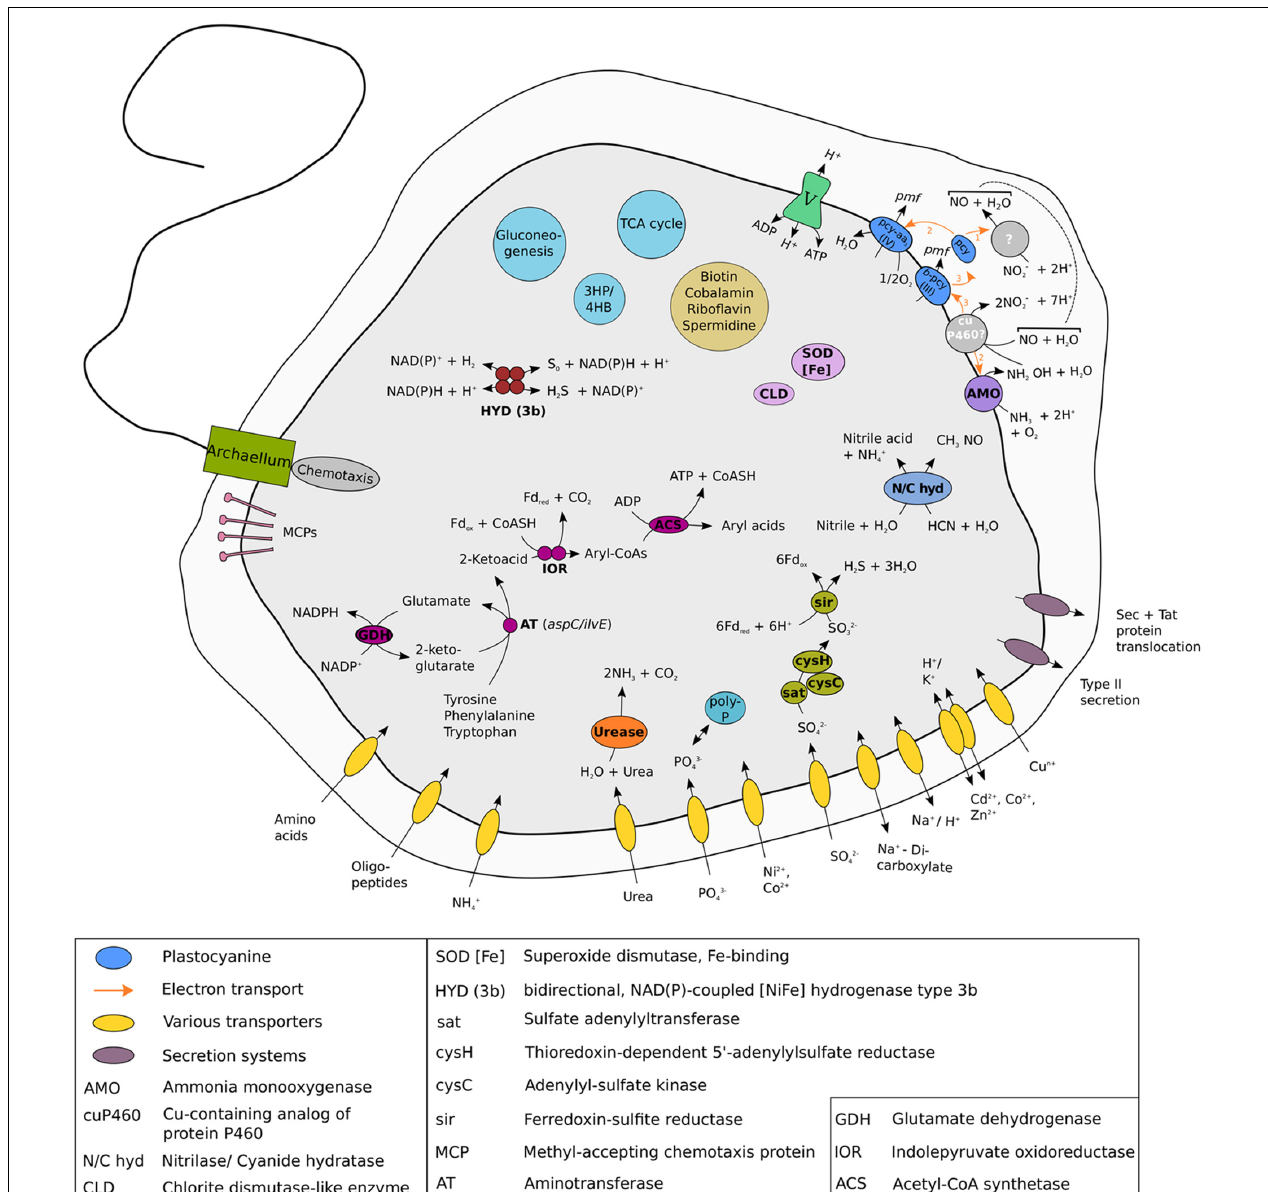
FIGURE 7 | Cell metabolic cartoon constructed from the annotation of the “ Ca. N. islandicus” genome. Enzyme complexes of the electron transport chain are labeled by Roman numerals. Most metabolic features displayed are discussed in the main text. The model of ammonia oxidation and electron transfer is depicted as proposed by Kozlowski et al. (2016). Locus tags of all genes discussed in the main text are given in Supplementary Table S4. Like some but not all AOA, “ Ca. N. islandicus” encodes all genes required to assemble an archaeal flagellar apparatus that is composed of the flagellar filament, the motor, and its switch (Mosier et al., 2012; Spang et al., 2012; Lebedeva et al., 2013; Lehtovirta-Morley et al., 2016; Li, 2016; Qin et al., 2017a), although no archaellum could be detected in our electron microscopic analysis. The fla gene cluster of “ Ca. N. islandicus” shows a similar arrangement to Nitrososphaera gargensis and contains six genes including one gene for structural flagellin subunit FlaB/FlaA as well as the flagellar accessory genes flaG , flaF , flaH , flaJ, and flaI (Spang et al.,